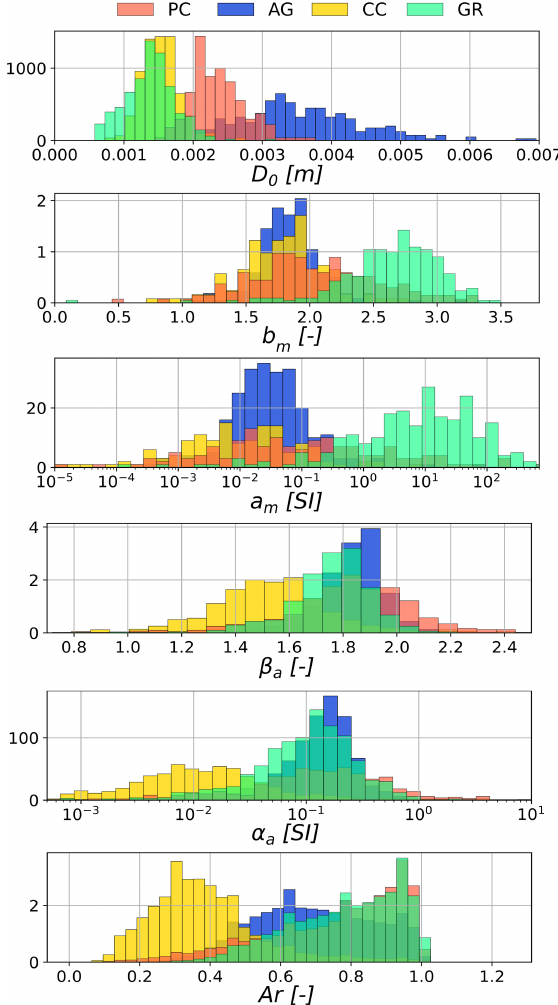
Figure B1. Histograms of the microphysical parameters in the MASC database. PC: planar crystals; AG: aggregates; CC: colum- nar crystals; GR: